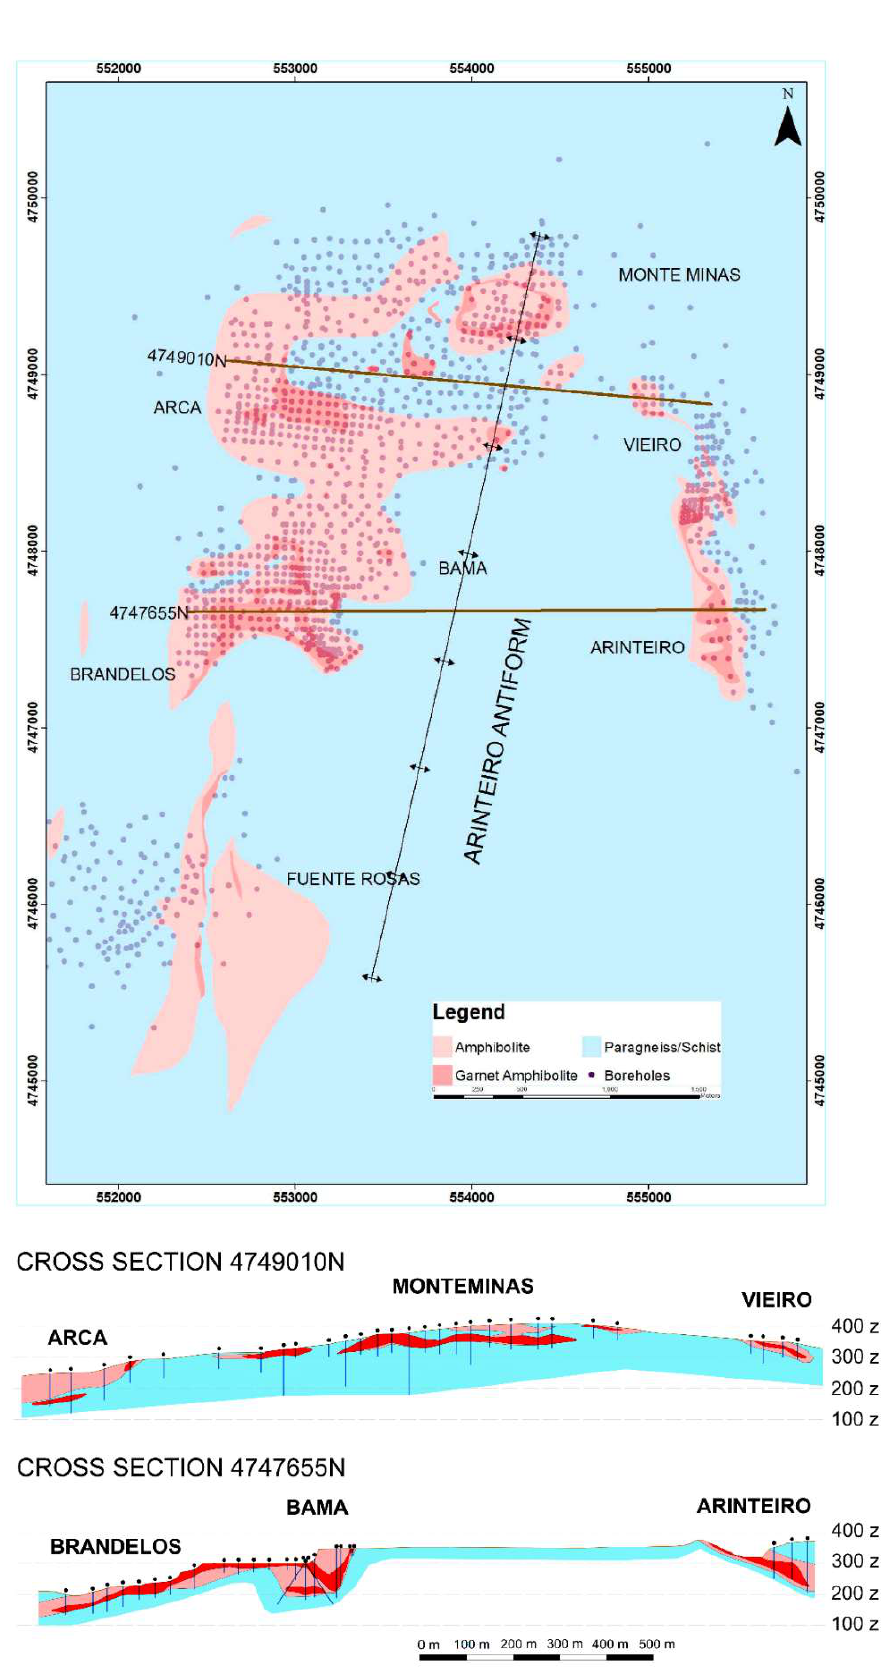
Figure 2. Geological map and cross-sections with borehole locations of the Touro copper deposit. All map co-ordinates are in UTM, and Z is in meters.